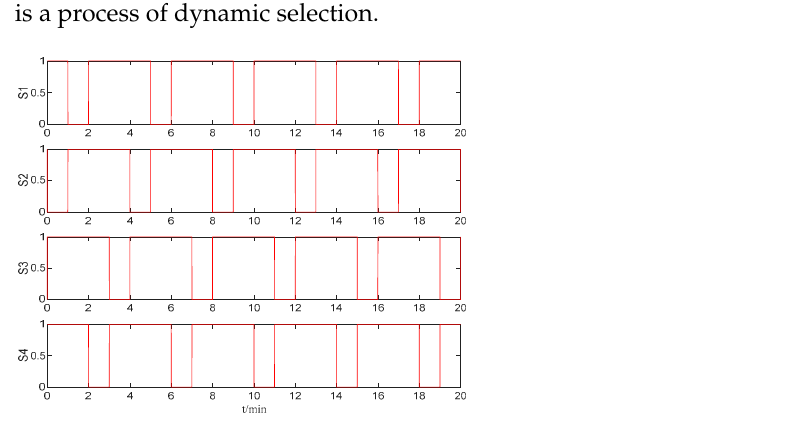
Figure 8. Relay switch action.